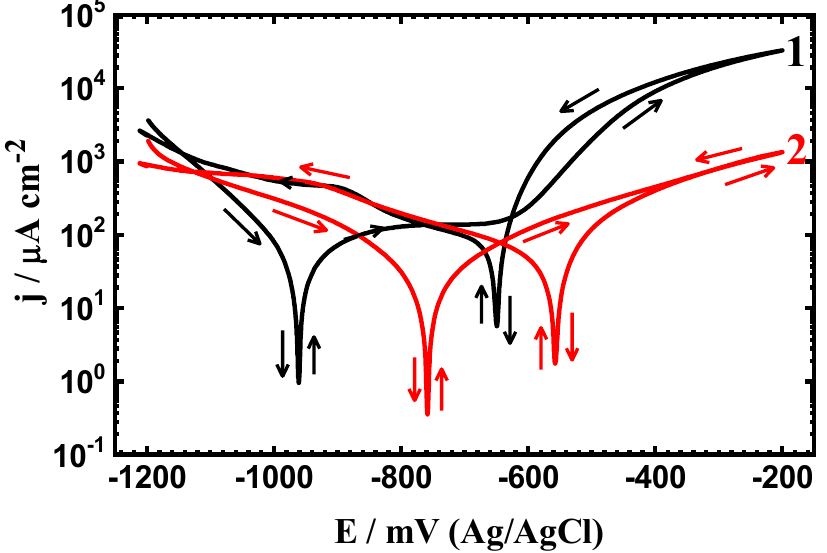
Figure 2. PCP curves of ( 1 ) API-2H steel and ( 2 ) 75%Cr 3 C 2 − 25%NiCr coated API-2H steel after exposure in 4% NaCl solution for 24 h.